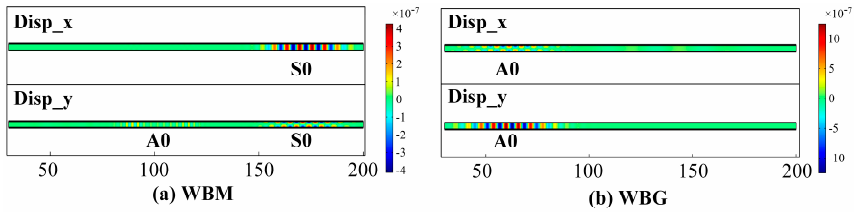
Figure 12. Displacement distribution of the WBM and WBG models at 36 µ s.